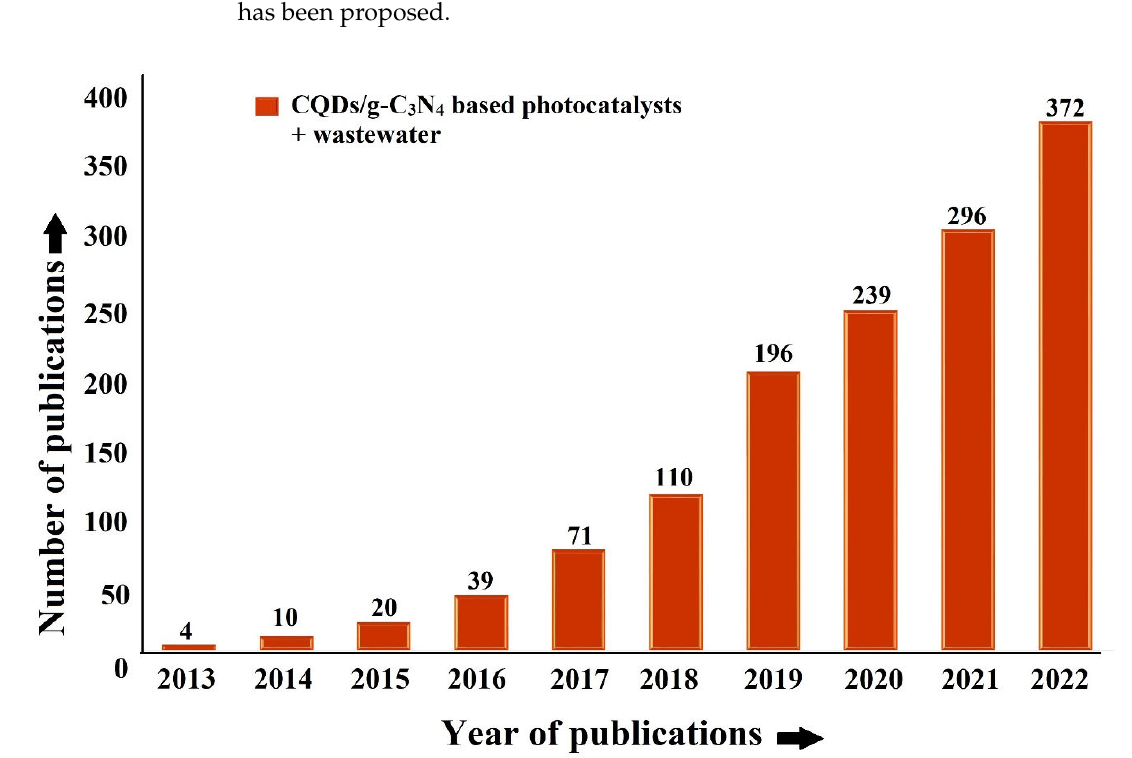
Figure 2. Overall publication detail on CQDs/g-C 3 N 4 -based photocatalysts for wastewater treatment from 2013 to 2022.